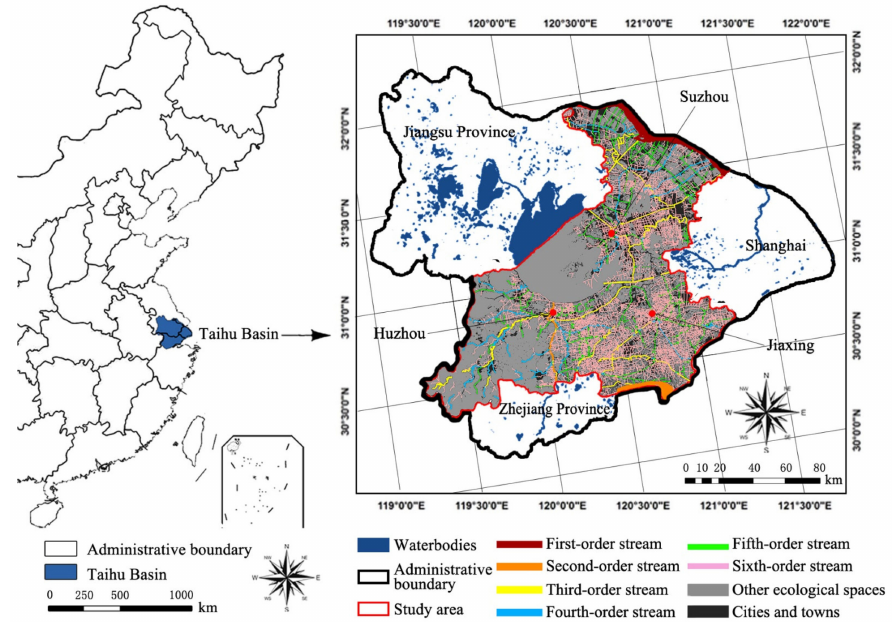
Figure 2. Location and six orders of streams of the study